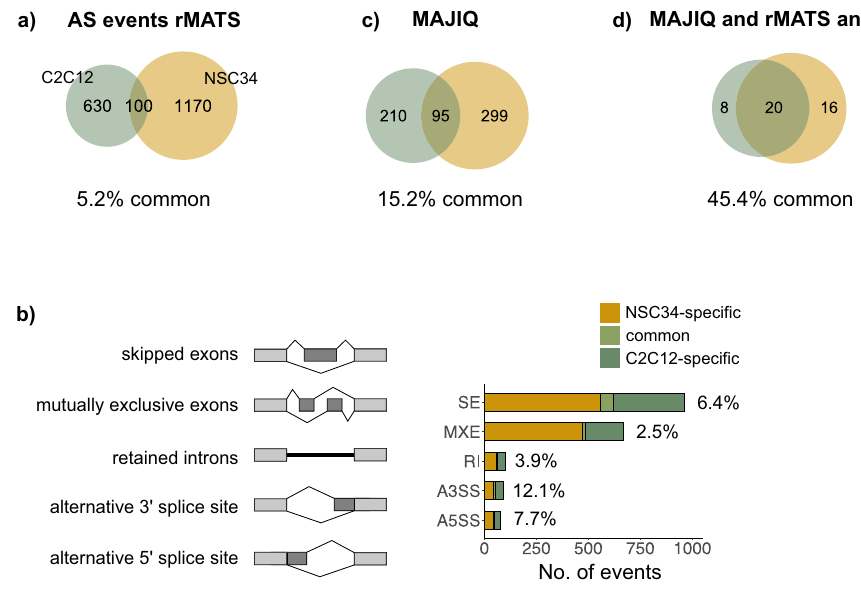
Fig. 3 TDP-43-regulated splicing changes show cell-type speci fi city. a Venn diagram shows the total number of AS events (detected by rMATS at FDR < 0.01) induced by TDP-43 depletion in C2C12 and NSC34 speci fi cally (630 and 1170, respectively), together with those commonly detected in both cell lines (100). b The number of annotated AS events (Fig. 3a, Supplementary Data 3) visualized by event type. SE - exon skipping, MXE - mutually exclusive exons, RI - intron retention, A3'SS and A5'SS - alternative 3' or 5' splice site. The percentage of overlapping AS events is reported on the plot. c Venn diagram shows the number of AS events (junctions) detected by MAJIQ ( Δ PSI > 0.2, FDR < 0.1, Supplementary Data 4). d Venn diagram showing the number of AS events detected by rMATS (Fig. 3 a, Supplementary Data 3) and MAJIQ (Fig. 3b, Supplementary Data 3), that were additionally validated using Interactive Genome